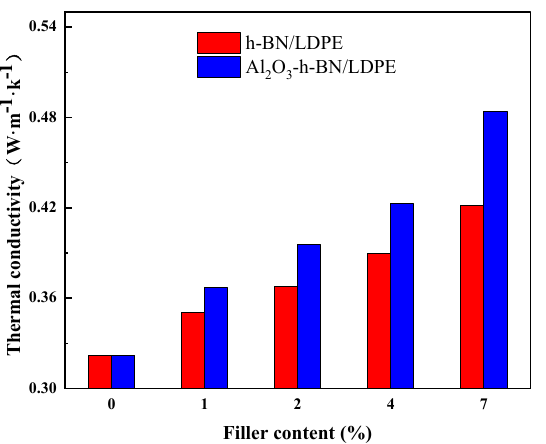
Figure 11. Thermal conductivity of h-BN/LDPE and Al 2 O 3 -h-BN/LDPE nanocomposite specimens with different doping contents.